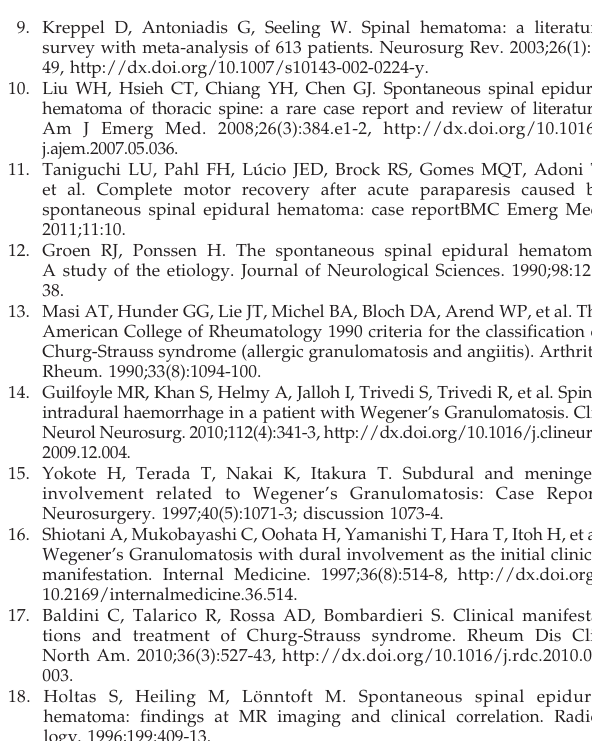
Figure 2 - Magnetic resonance imaging of the thoracic spine. Sagittal T2-weighted imaging reveals a hyperintense posterior mass extending from T5-T6 to T7-T8 (white arrows), which compresses the spinal